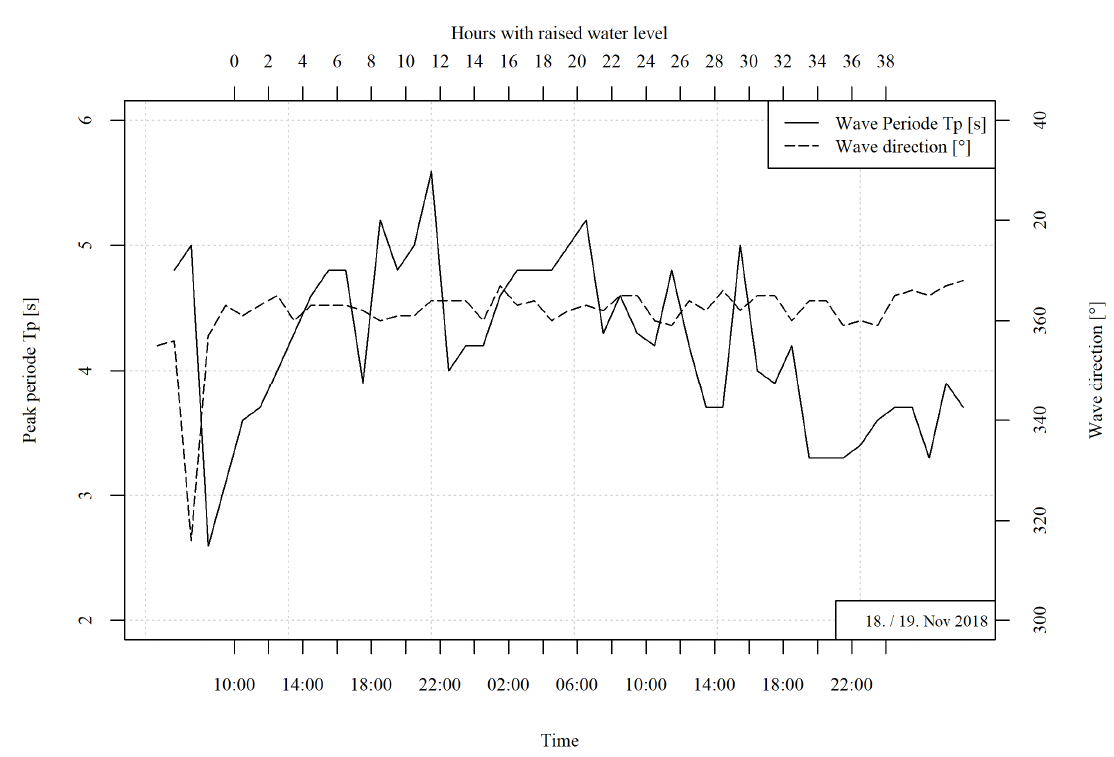
Figure 11. Wave period and wave direction of the storm surge 18/19 November 2018.